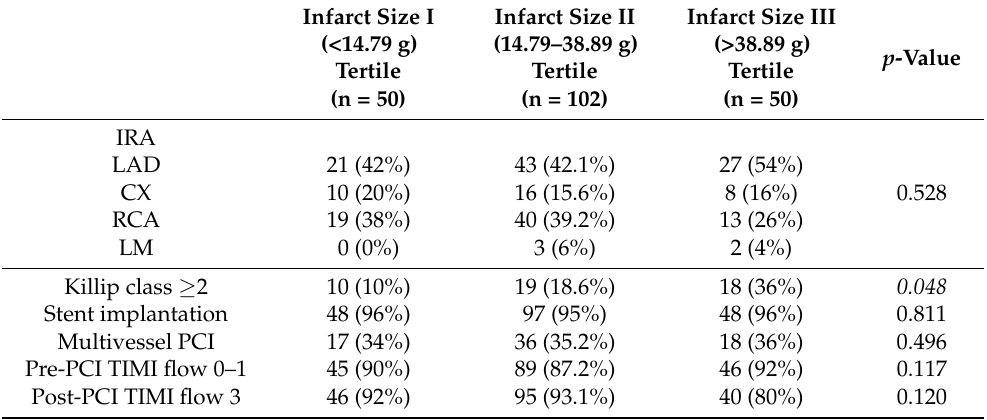
Table 2. Angiographic and PCI procedure characteristics of the study